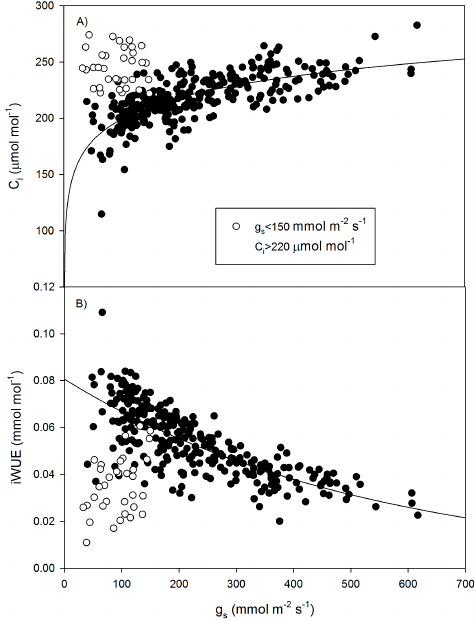
Figure 2. Relationship between ( A ) the sub stomatal CO 2 concentration (C i , μ mol mol − 1 ) and ( B ) intrinsic water use efficiency (iWUE, mmol mol − 1 ) relative to stomatal conductance (g s , mmol m − 2 s − 1 ). Data characterized by g s < 150 mmol m − 2 s − 1 and C i > 220 μ mol mol − 1 (average of the population) were plotted separately. The best fit relationship for C i was performed using a logarithmic function: y = 71.8 + 26.7 × ln(abs( x )); r 2 = 0.52. The best fit relationship for iWUE was performed using an exponential function: y = 0.80 × e ( − 0.019 x ) ; r 2 = 0.58.